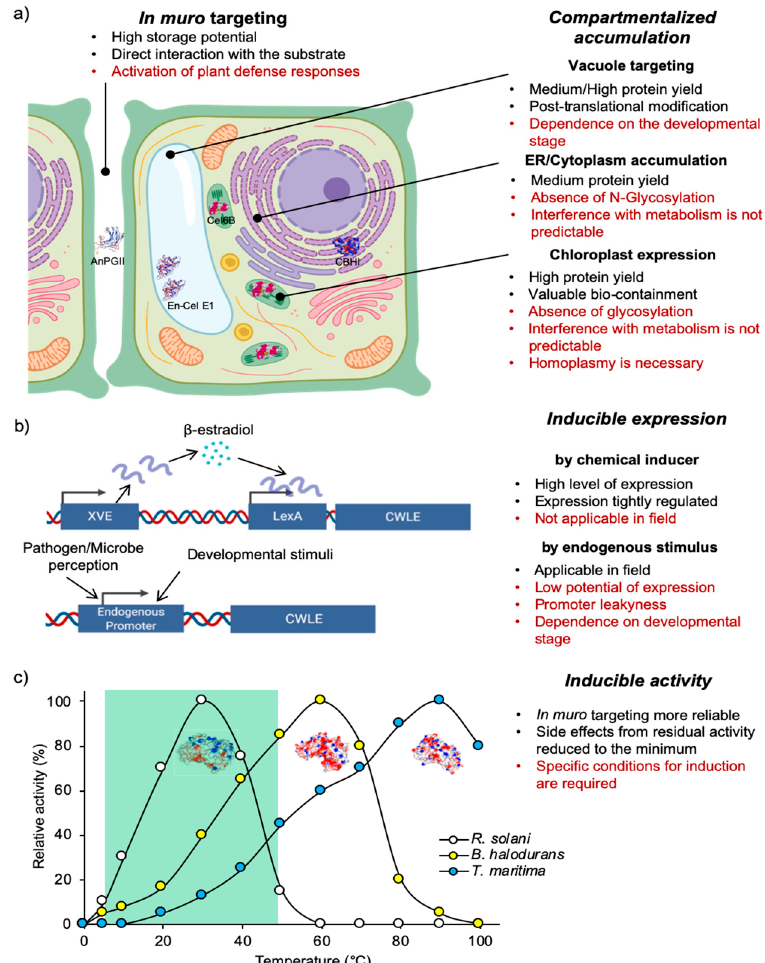
Figure 3. Plant production of microbial CWLEs. Production of CWLEs as obtained by ( a ) constitutive expression and compartmentalization or ( b ) inducible gene expression. Advantages and disadvantages of each strategy are indicated in black and red, respectively. In ( a ), the represented CWLEs were successfully produced upon compartmentalized expression. ( c ) Theoretical optimal temperature of XynA from the mesophilic fungus R. solani , from the thermophilic bacterium B halodurans, and from the hyperthermophilic bacterium T. maritima, here reported as a representative set of CWL isoenzymes. Activity of XynA from T. maritima is strongly reduced in the temperature range of plant growth (green box) and increases the chance of preserving the productivity of the transgenic plant. AnPGII: endo-1,4- α -polyglacturonase II from A. niger (98); Cel6B: endo-1,4- β -glucanase from T. fusca , (100); En-Cel E1: endo-1,4- β -cellulase from A. cellulolyticus , (102); and CBHI: cellobiohydrolase I from T. reseei, (104).